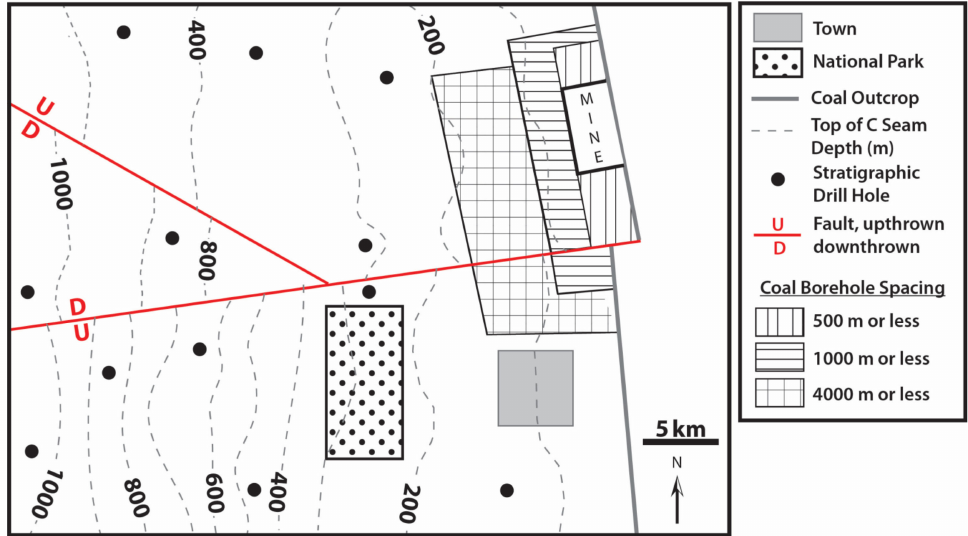
Figure 8. Hypothetical vertical section showing stratigraphy and status relative to mining and CSG utilisation.